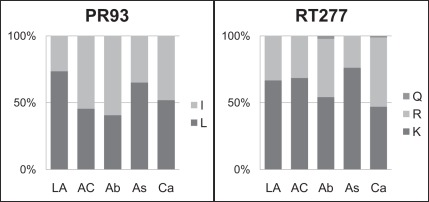
Amino acid frequency distributions at sites PR93 and RT277.For each ethnic group, the frequencies of alternative amino acids are shown for two sites in protease (PR) and reverse transcriptase (RT). Amino acids represented are: leucine (L), isoleucine (I), glutamine (Q), arginine (R) and lysine (K). FST values at PR93 and RT277 are 0.06 and 0.0521, respectively. Notation of ethnicities is as follows: Aboriginal (Ab), African-Caribbean (AC), Asian (As), Caucasian (Ca), and Latin American (LA).